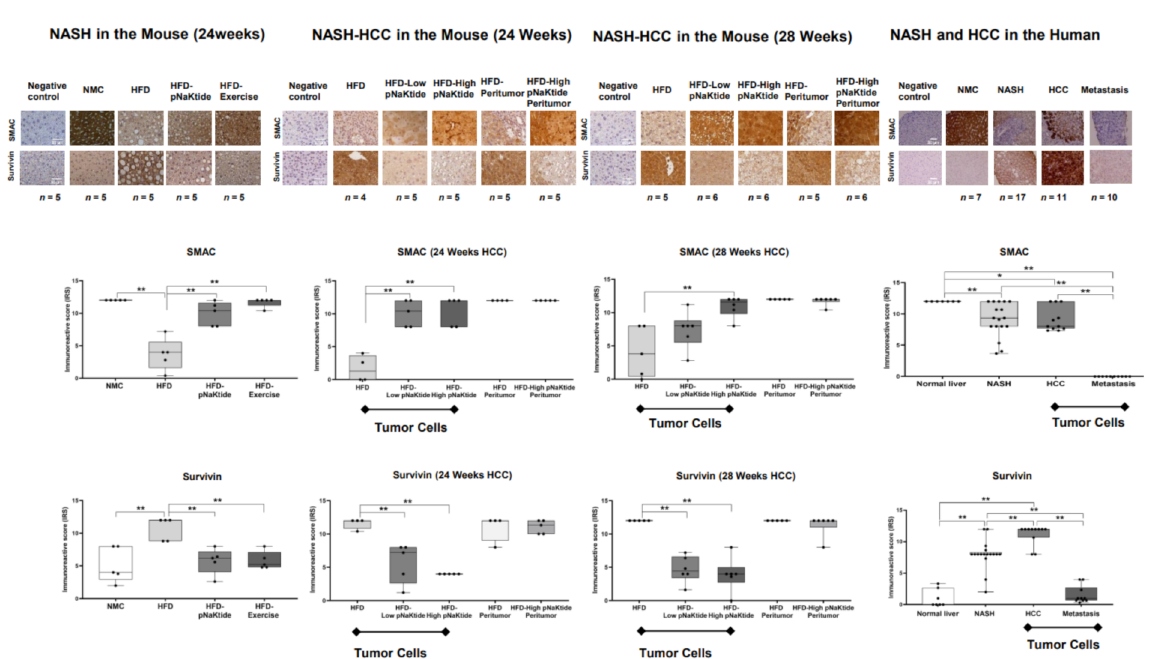
Figure 5. Effect of α 1-Na/K-ATPase signalosome normalization on survivin and SMAC proteins expression in NASH and NASH-HCC mouse models and human liver tissues. There was a significant down-regulation of survivin and upregulation of SMAC expressions in tumor cells from treated vs. non-treated animals at 24 and 28 weeks (** p < 0.01, by ANOVA and Tukey’s post hoc test). There were no significant changes in protein expressions in the peritumor cells of mice in the HFD groups vs. high pNaKtide-treated groups in the NASH-HCC mice model (24 and 28 weeks). In human tissues, the findings were consistent with the in-vitro and in-vivo findings for both survivin and SMAC proteins. There was a significant upregulation of survivin expression in livers from patients with NASH and HCC when compared with livers from normal subjects and patients with liver metastases (** p < 0.01). On the contrary, SMAC expression significantly decreased in livers from patients with NASH, HCC, and liver metastases when compared with livers from the normal subjects (* p < 0.05; ** p <